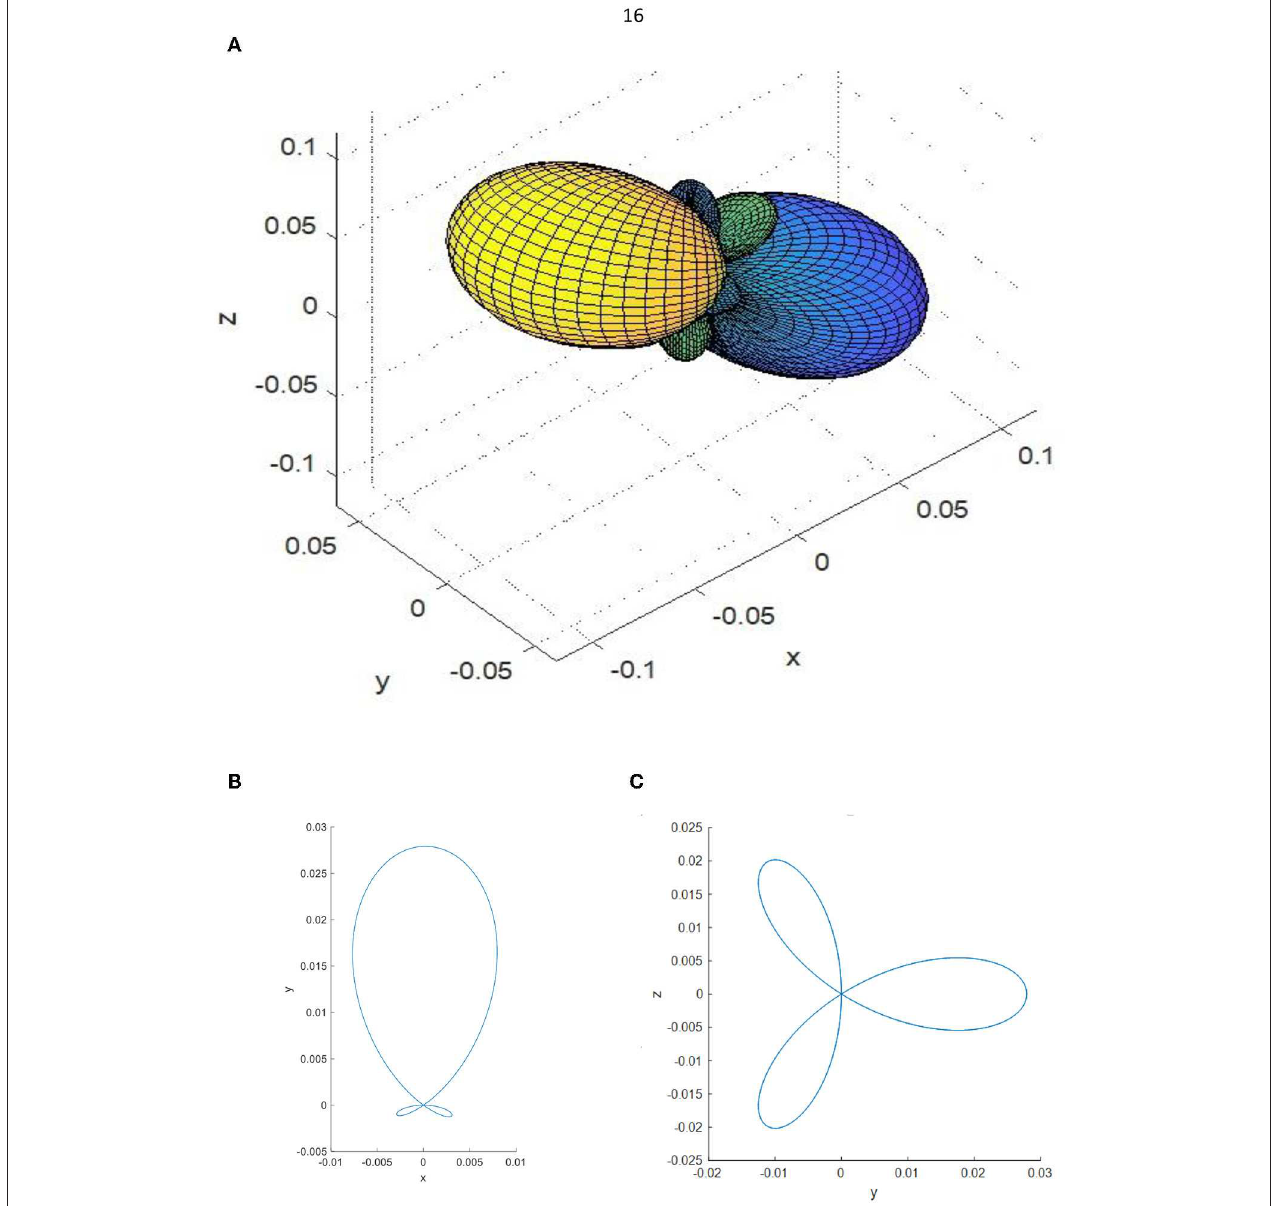
FIGURE 5 | (A) 3D plot, (B) xy 2D plot, and (C) yz 2D plot of the piezoelectric tensor of α -DIPAB.